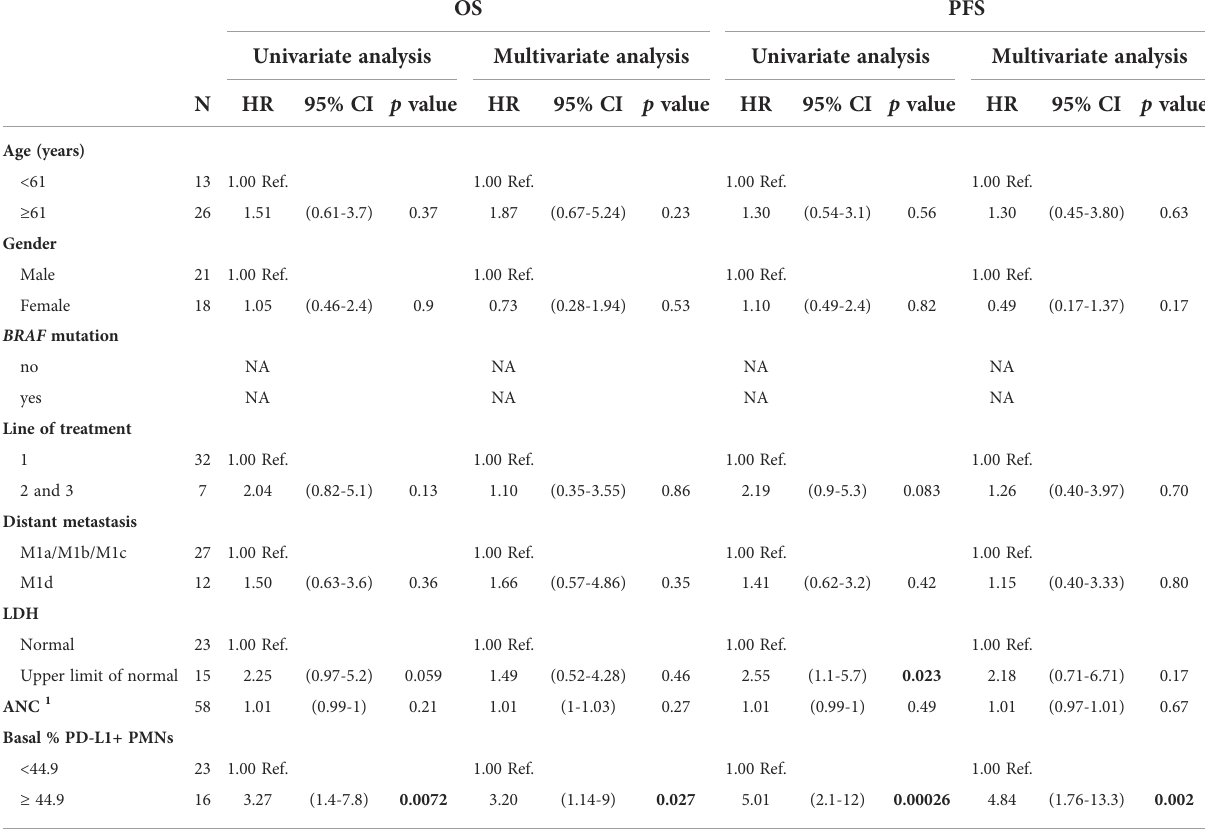
TABLE 2 Univariate and multivariate analyses for OS and PFS in BRAF Wild type advanced melanoma patients. OS